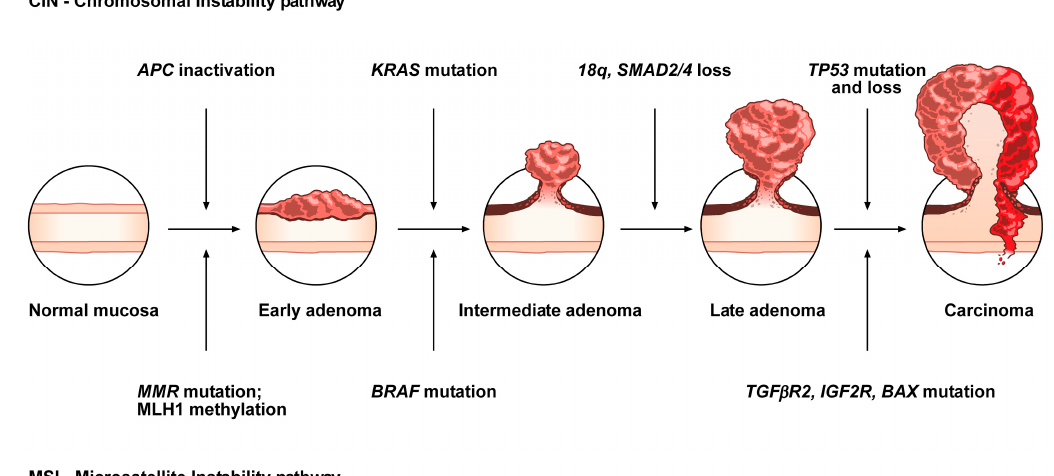
Figure 1. Conventional adenoma-to-carcinoma sequence. The chromosomal instability (CIN) pathway begins with bi-allelic mutations in the tumor suppressor gene APC within the normal colonic mucosa. The latter progressively differentiate into adenocarcinoma upon acquisition of additional mutations in the genes KRAS , SMAD4, and TP53 , with consequent dysregulation of the Wnt/ β -catenin, MAPK , PI3K and TGF- β signaling pathways. Alternatively, the MSI pathway involves an initial alteration of the Wnt signaling that leads to the formation of an early adenoma. Then, BRAF mutation followed by alterations of the genes TGFBR2 , IGF2R , and BAX, participate in the progression toward the intermediate and late stages of carcinogenesis.